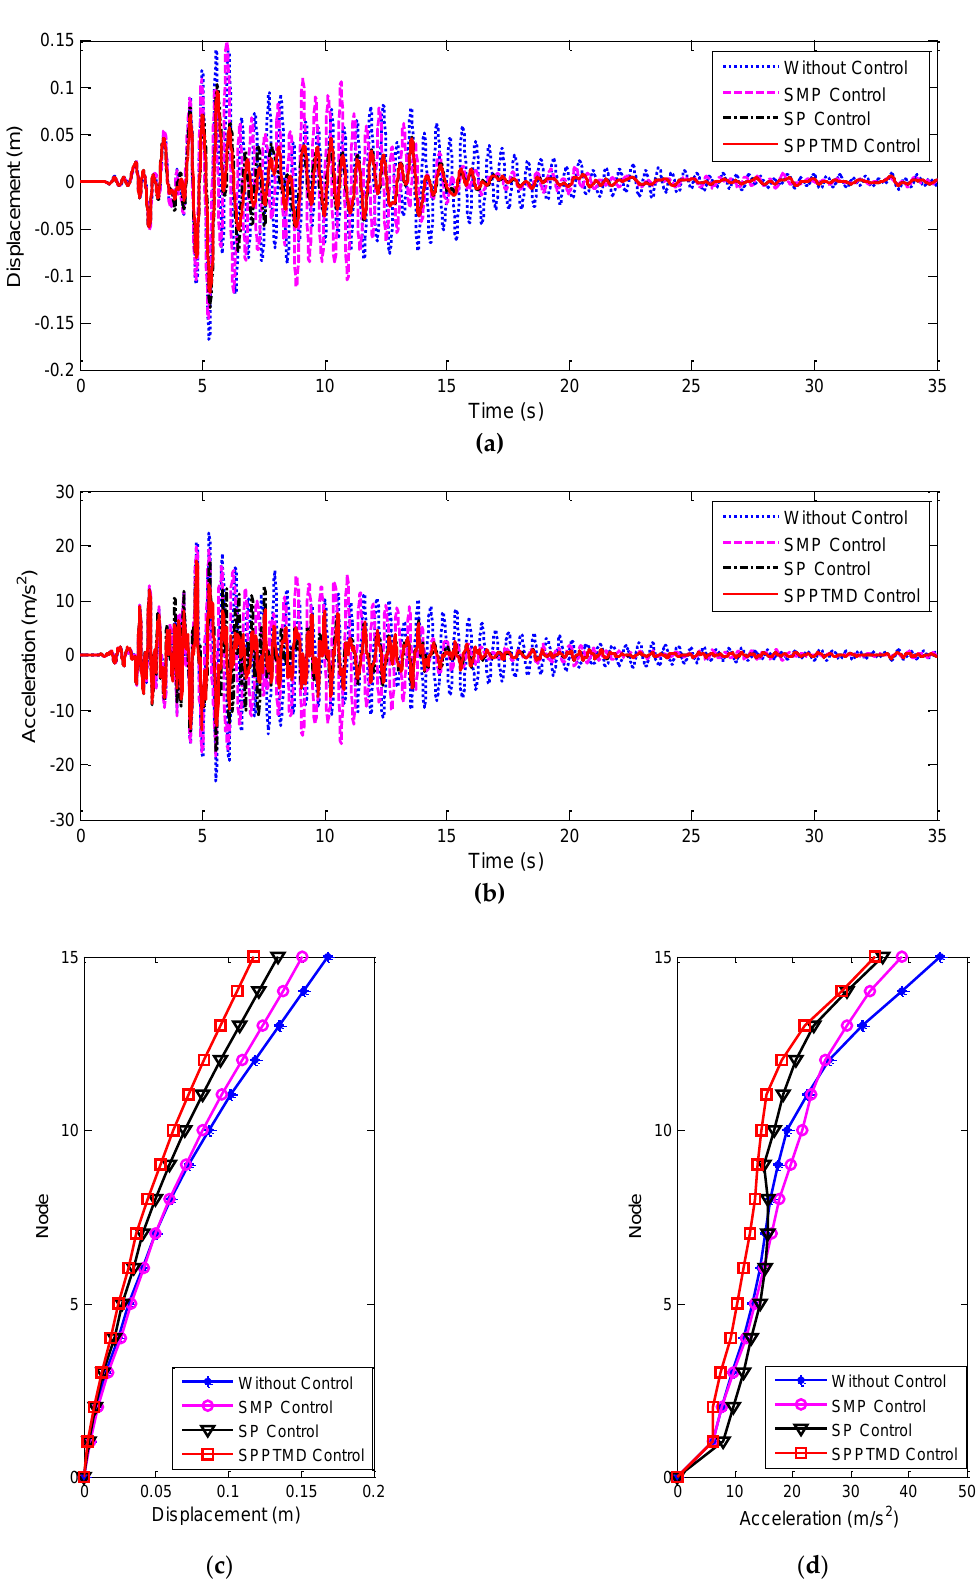
Figure 12. Seismic response of the tower top under EQ3: ( a ) displacement; ( b ) acceleration; ( c ) envelope of displacement; and ( d ) envelope of acceleration.